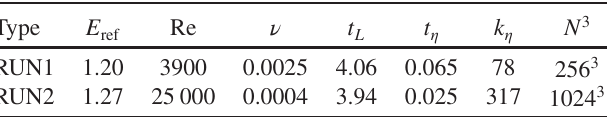
TABLE I. Parametersusedforthedifferentreferencesimulations experiments. All the respective nudged simulations have the same parameters. The code uses a two-step Adams-Bashfort scheme for the time integration, and the “ 2 = 3 rule ” for dealiasing. The values 2 , the Reynolds listed are the total kinetic energy E ¼ 1 = 2 hj u ref ji number Re ¼ L ð 2 E Þ 1 = 2 = ν , the viscosity ν , the eddy turnover time ffiffiffiffiffiffiffiffiffiffiffiffiffiffiffiffiffiffiffiffiffiffiffi p ν L= ð 2 E Þ 3 = 2 , the Kolmogorov wave number k η ¼ ½ ν 3 L= ð 2 E Þ 3 = 2 (cid:2) − 1 = 4 , and the number of grid points N 3 . The largest scale of the flow L is equal to 2 π in all simulations. In both cases f is a randomly generated, ref quenched in time, isotropic field with support on wave numbers with amplitudes k ∈ ½ 1 ; 2 (cid:2) whose Fourier coefficients are